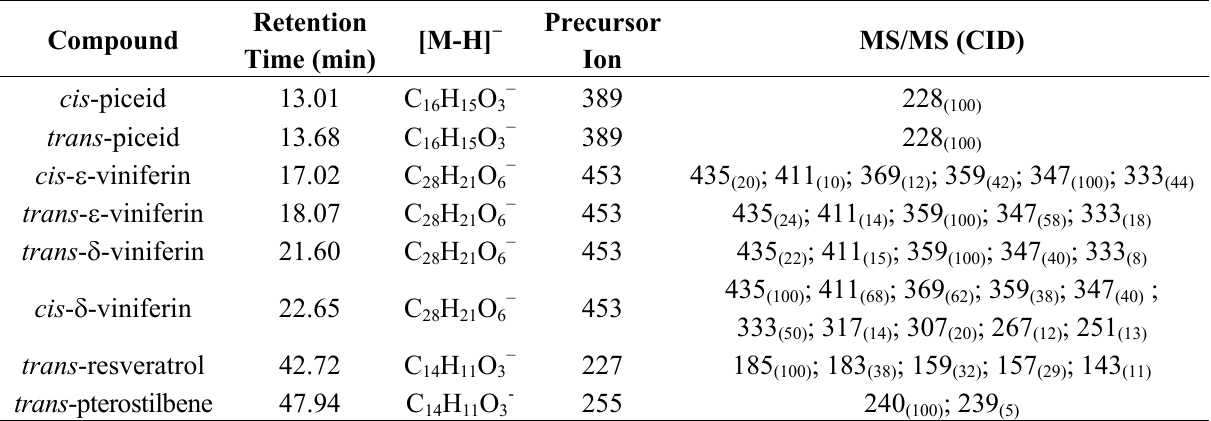
Table 2. List of retention times, molecular formulae and MS/MS product ions of stilbenes detected by LC-ESI/MS (see also Figure 1). The relative intensities of fragments are indicated in parenthesis.